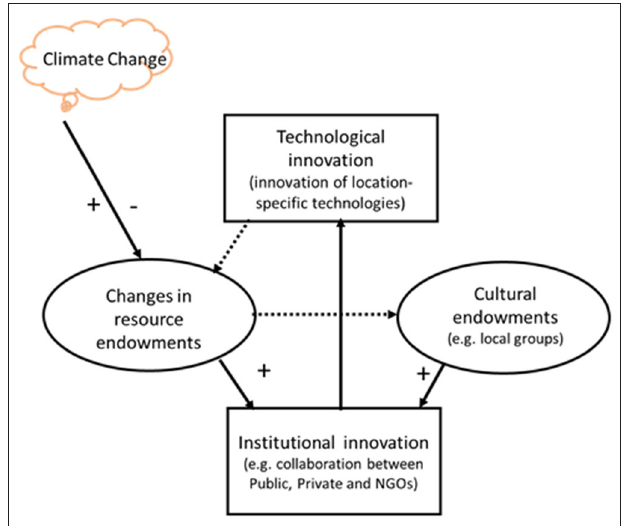
FIGURE 1 | A conceptual model illustrating the integration between institutional, cultural, and technological innovation (source: Chhetri et al.,